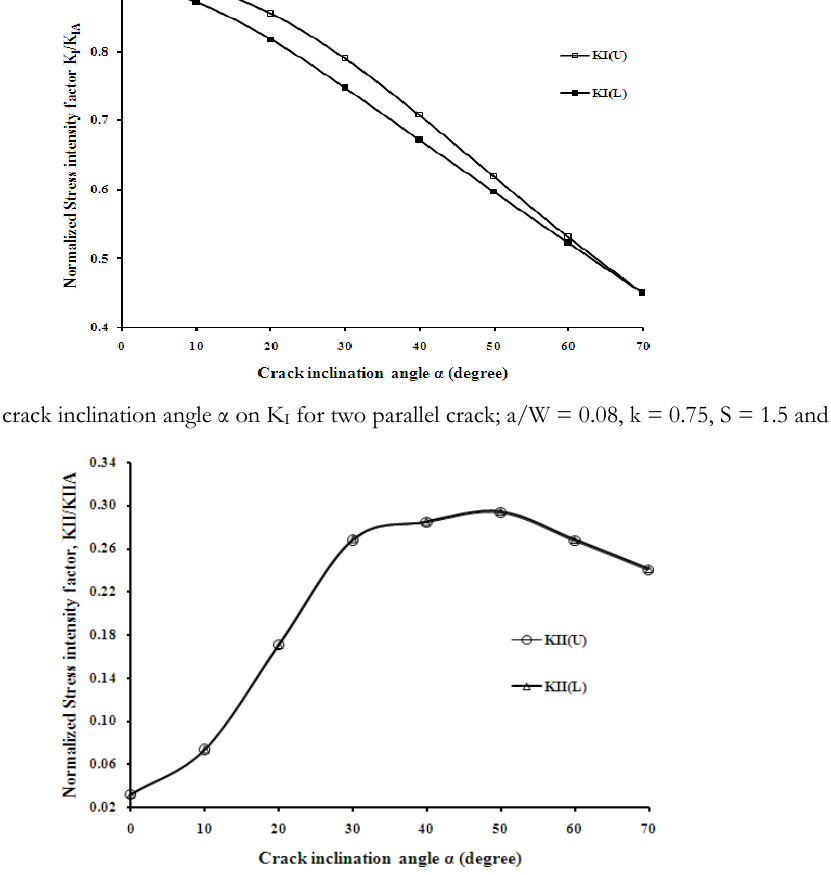
Figure 11: Effect of crack inclination angle α on K I for two non-parallel cracks; a/W =0.08, k = 0.75, S = 1.5 and B = 24mm.